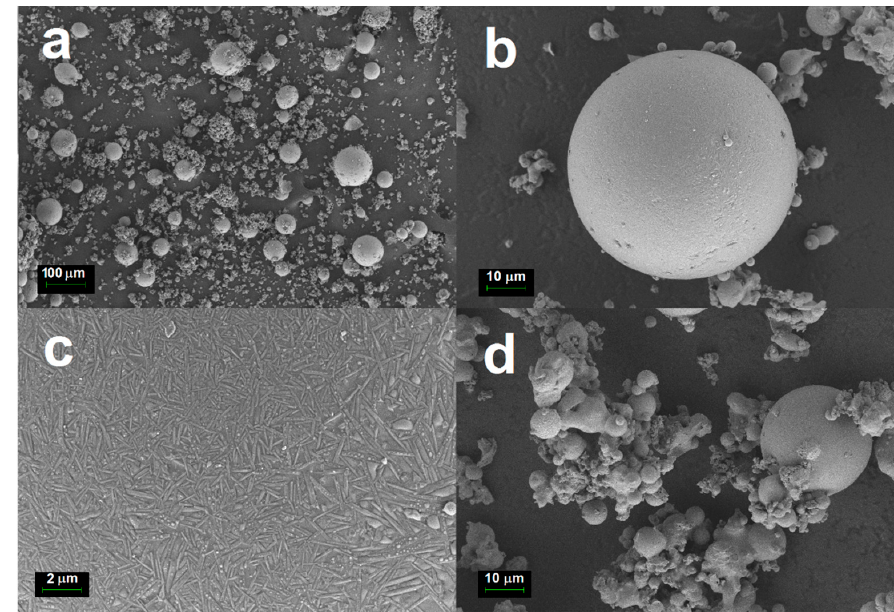
Figure 3. FESEM images showing the ( a ) size distribution of the cenospheres particles ( b ) cross-section and ( c ) outer surface and ( d ) inner surface of a single cenosphere particle in closer views.